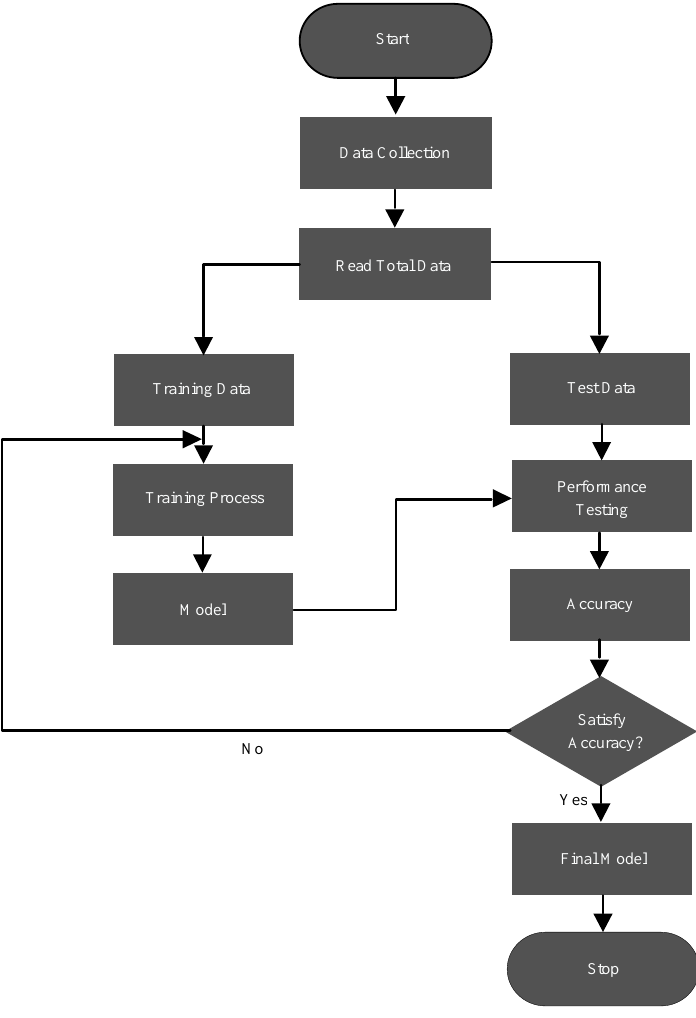
Figure 2. Flowchart of research methodology